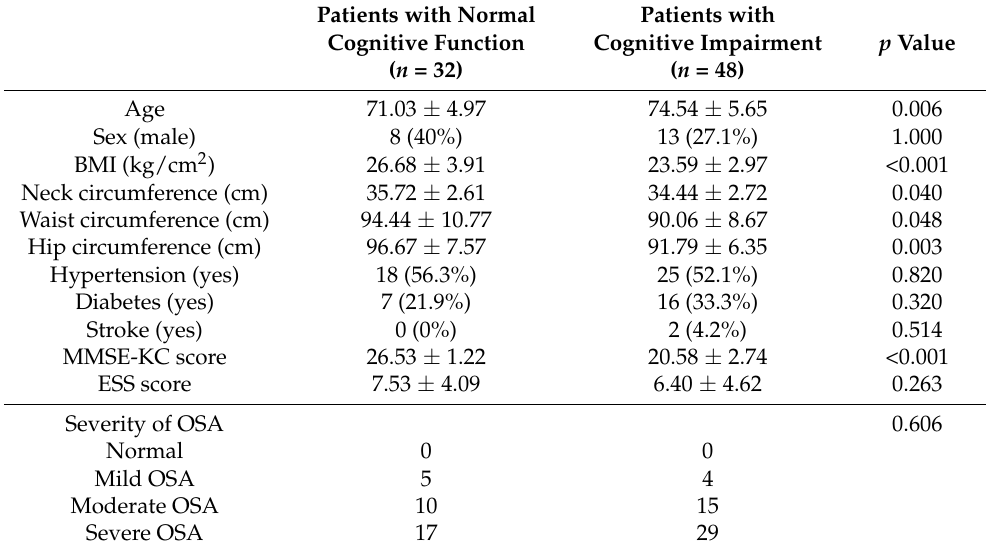
Table 1. Characteristics of study